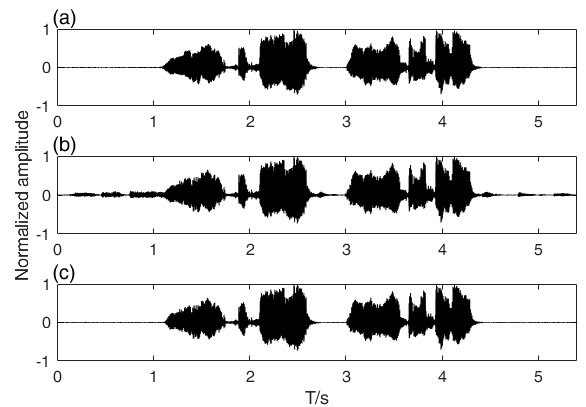
Figure 3. Signal denoised by DNNs. ( a ) Original signal; ( b ) mixed signal; ( c ) estimated signal.